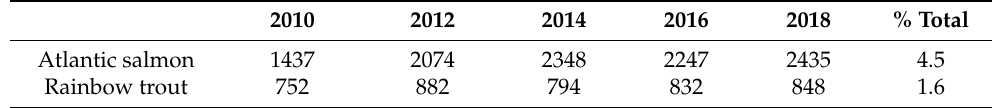
Table 5. World production of the main salmonid species ( × 1000 t).